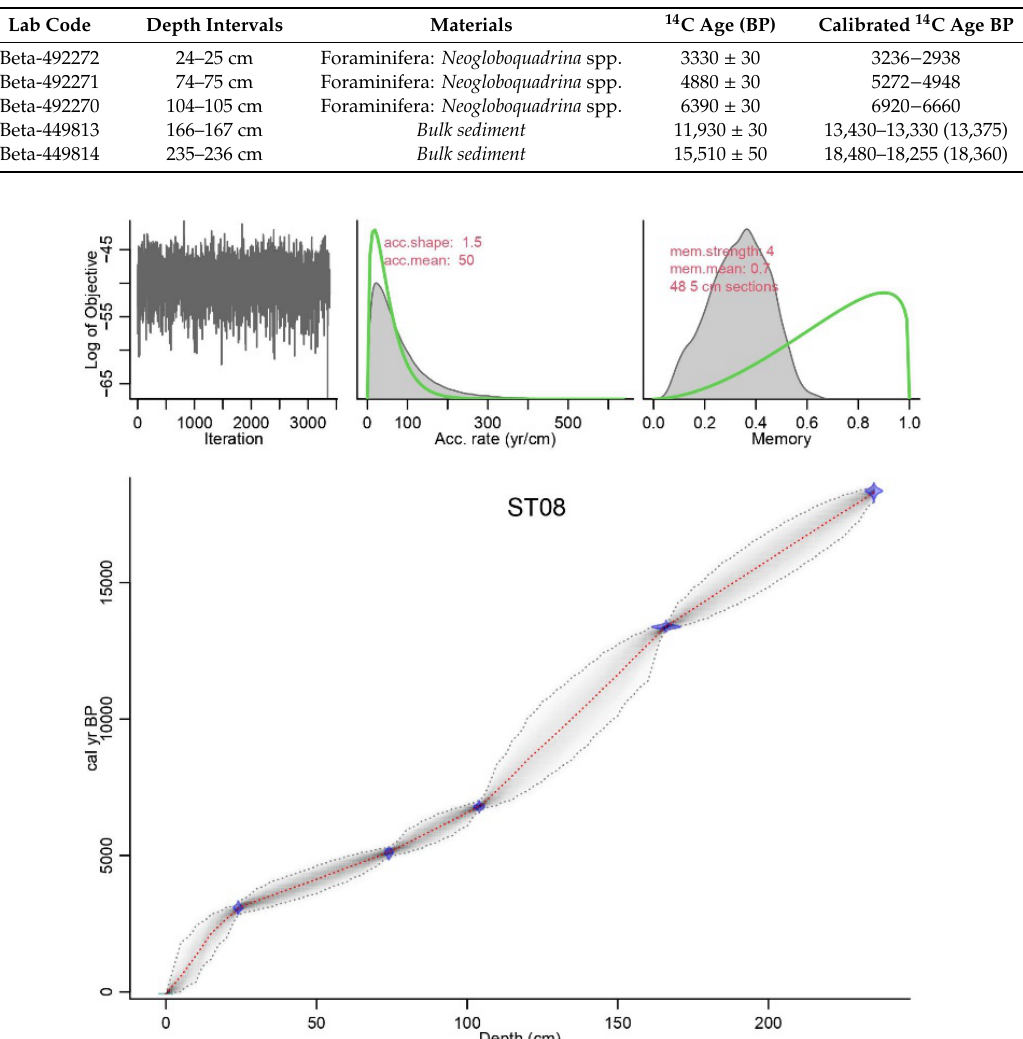
Figure 4. ST08 age model based on Bayesian approach [77] using rbacon package (version 2.4.2) [78] in R [79]. Upper panels depict the Markov chain Monte Carlo (MCMC) iterations (left panel), the prior (green curves) and posterior (grey histograms) distributions for the accumulation rate (middle panel) and memory (right panel) [78]. Bottom panel shows the calibrated 14 C dates (transparent blue) and the age-depth model (darker grays indicate more likely calendar ages, gray stippled lines show 95% confidence intervals, and red curve shows single 'best' model based on the mean age for each depth) [78].